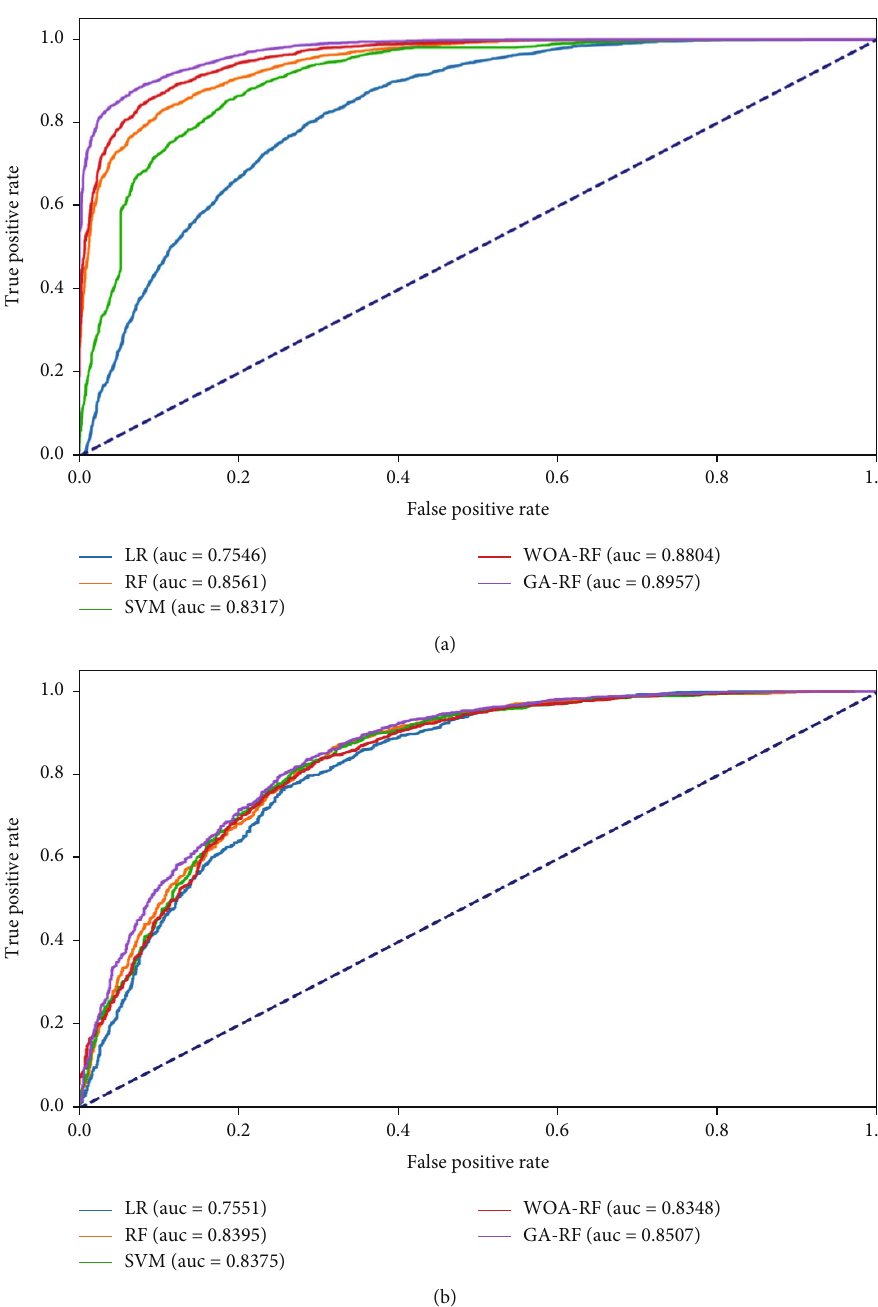
Figure 9: ROC curves of fi ve landslide susceptibility models using (a) training and (b)